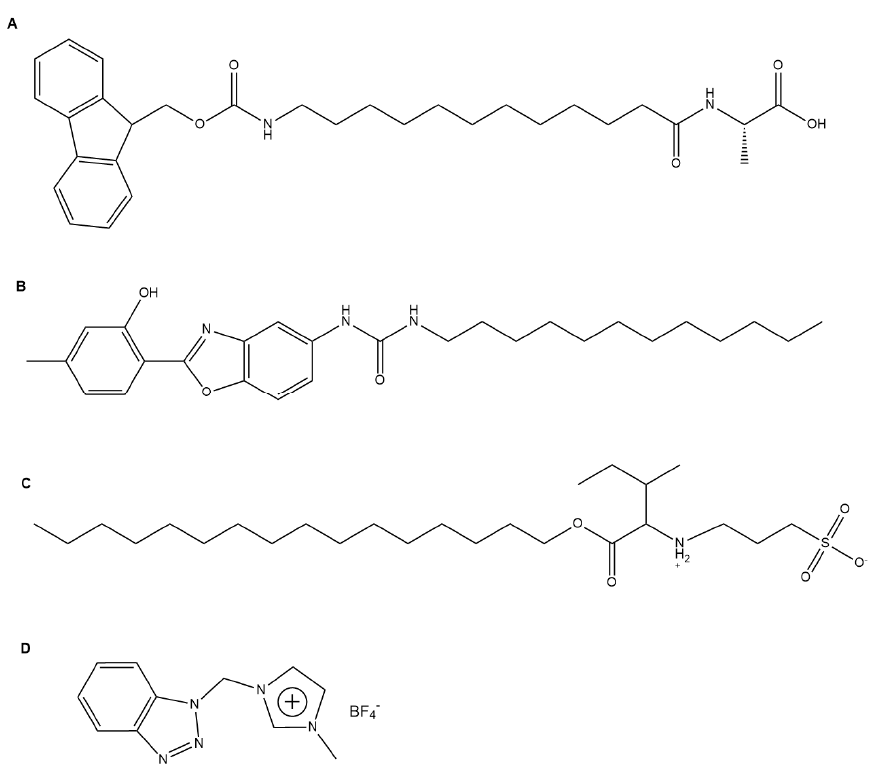
Figure 14. Selected gelators developed for special topic applications: ( A ) an ambidextrous bifunctional hydrogelator for the removal of toxic cationic and anionic organic dyes from water [130]; ( B ) an organogelator containing 2-(2 ′ -hydroxyphenyl)benzoxazole for the visual detection of nerve agents [133]; ( C ) a zwitterionic gelator for tribology [134]; and ( D ) an imidazolium-based gelator containing a benzotriazole group for anticorrosion and lubrication [135].